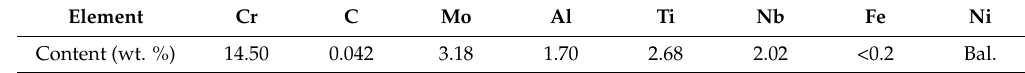
Table 1. Chemical compositions of the studied